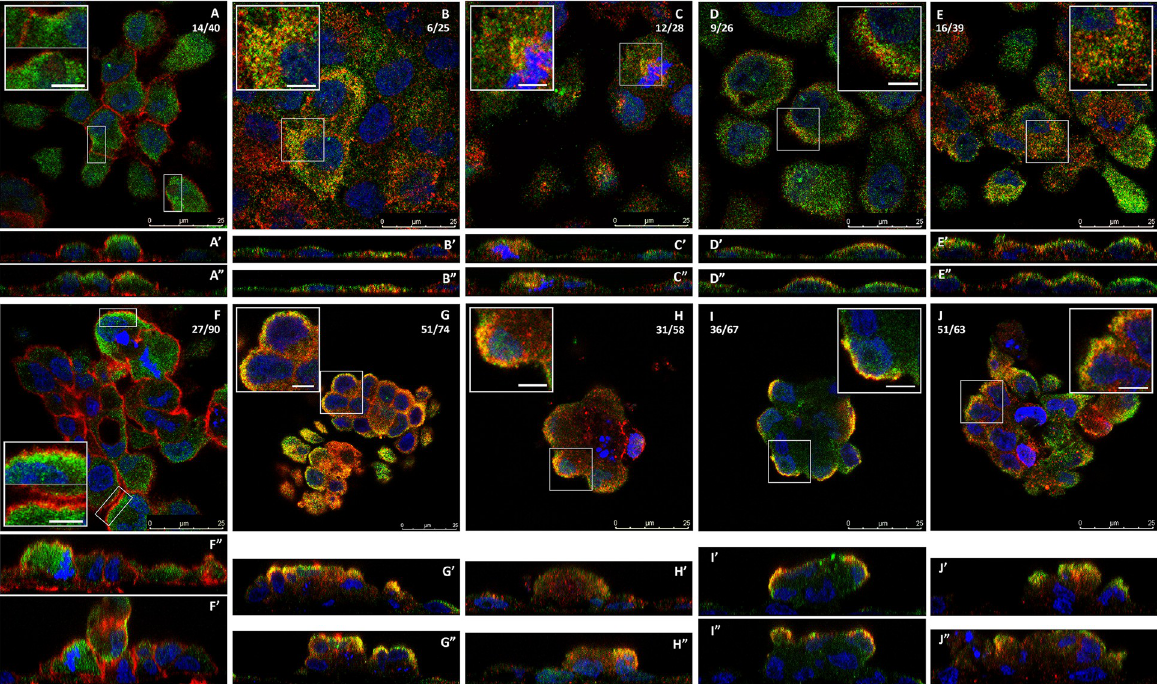
Fig 6. Intracellular co-localization of MT-3 and its binding partners. Images of MT-3 co-localization with the identified binding partners are shown in individual z-sections (0.35 μ m depth) for the non-doming monolayer (A-E) and a doming region (F-J). Larger panels have the 25 μ m scale bar indicated on the bottom left, and there is an inset indicated with a higher magnification image that contains a 5 μ m scale bar. Respective orthogonal views are shown for each image and are indicated (’) for scanning along the x-axis and (") for scanning along the Y-axis. In each panel MT-3 staining is shown in green and the binding partners in red: F-actin (A and F); myosin-9 (B and G); tropomyosin 3 (C and H); enolase 1 (D and I); aldolase A (E and J). The z-section level is shown as a ratio relative to the total z-images taken for that panel.